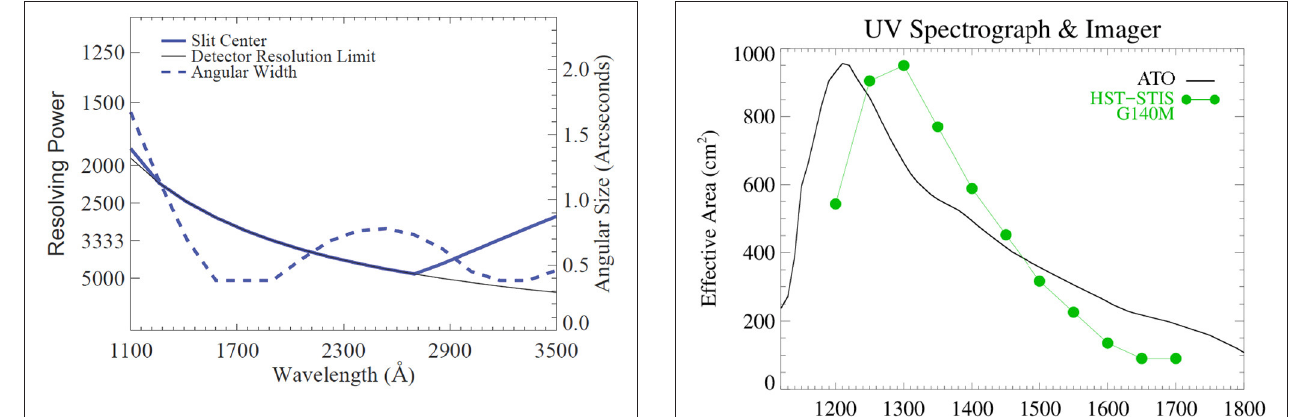
FIGURE 8 | MUVI UV spectral and imaging resolution. The solid curve shows the spectral resolving power and the dashed curve shows the angular resolution of MUVI.